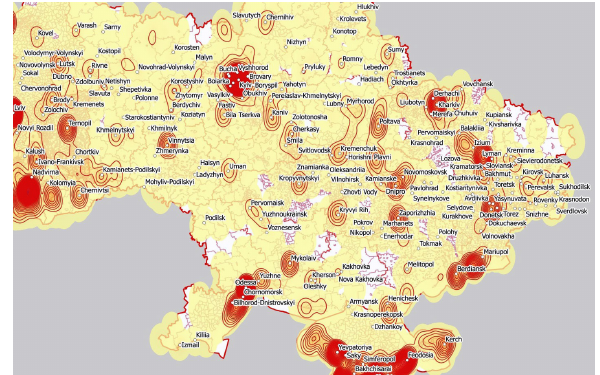
Figure 6. A fragment of a heatmap with isolines (the distribution of tourist and recreational objects on the territory